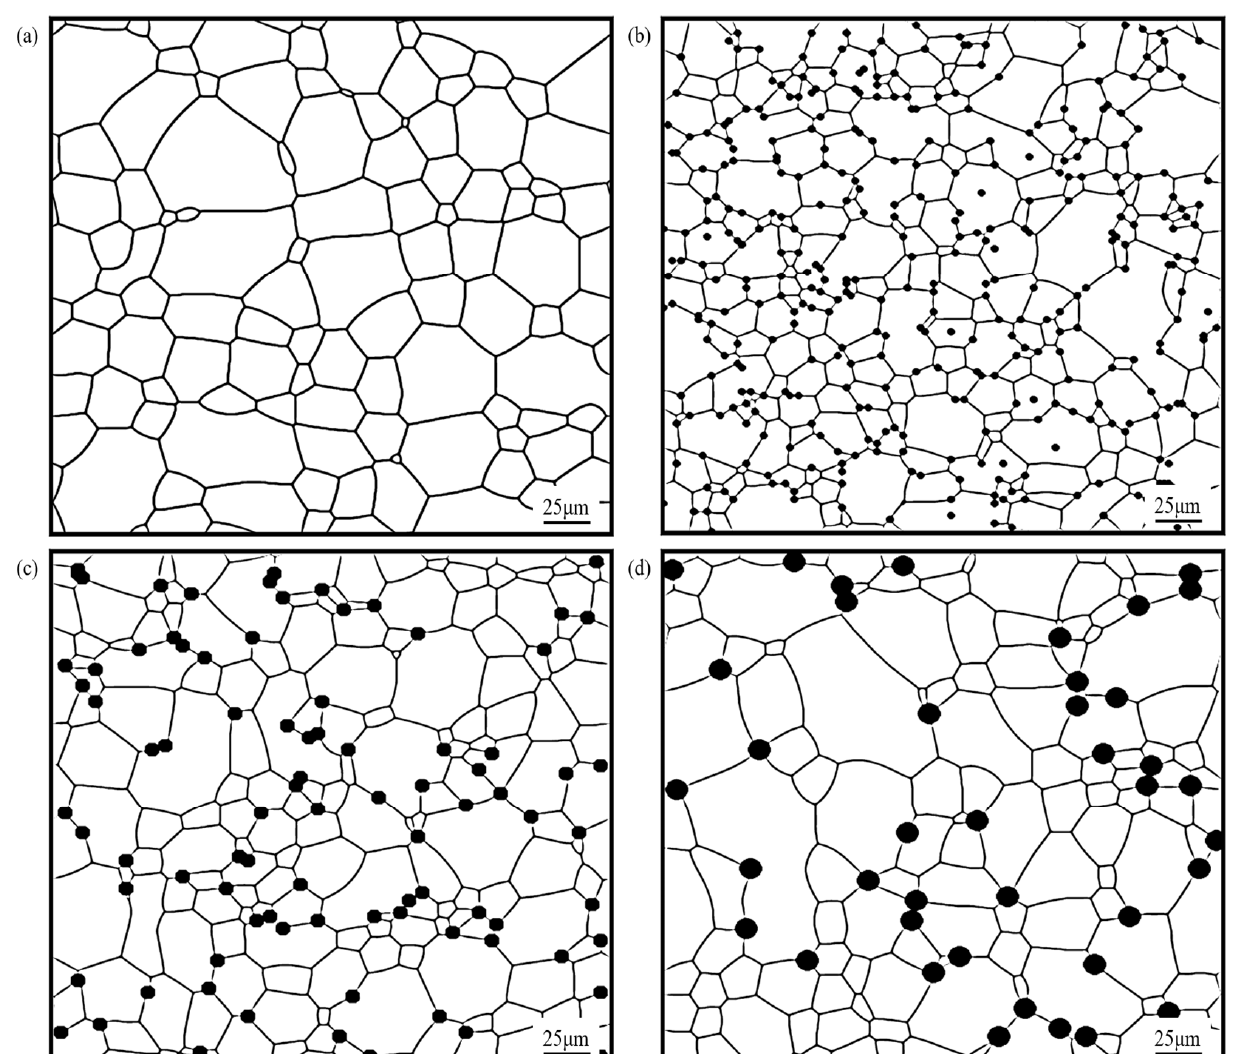
Figure 5. Simulated results of grain growth at t = 100 min with varying sizes of the SPP: ( a ) f = 0%; ( b ) f = 5%, and r = 1 μ m; ( c ) f = 5%, and r = 2 μ m; ( d ) f = 5%, and r = 3 μ m.